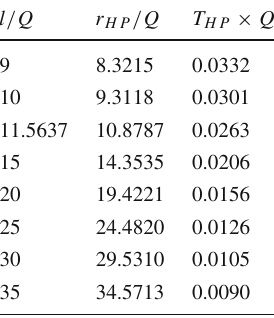
Fig. 7 Plots of the reduced Gibbs free energy G / Q as a function of the reduced temperature T × Q under the different values of the pressure. The orange, green, dashed black, blue, red, and blackcurves correspond to l / Q = 9 , 10 , ≈ 11.5637 , 15 , 20 , ∞ . Table 2 The numerical results